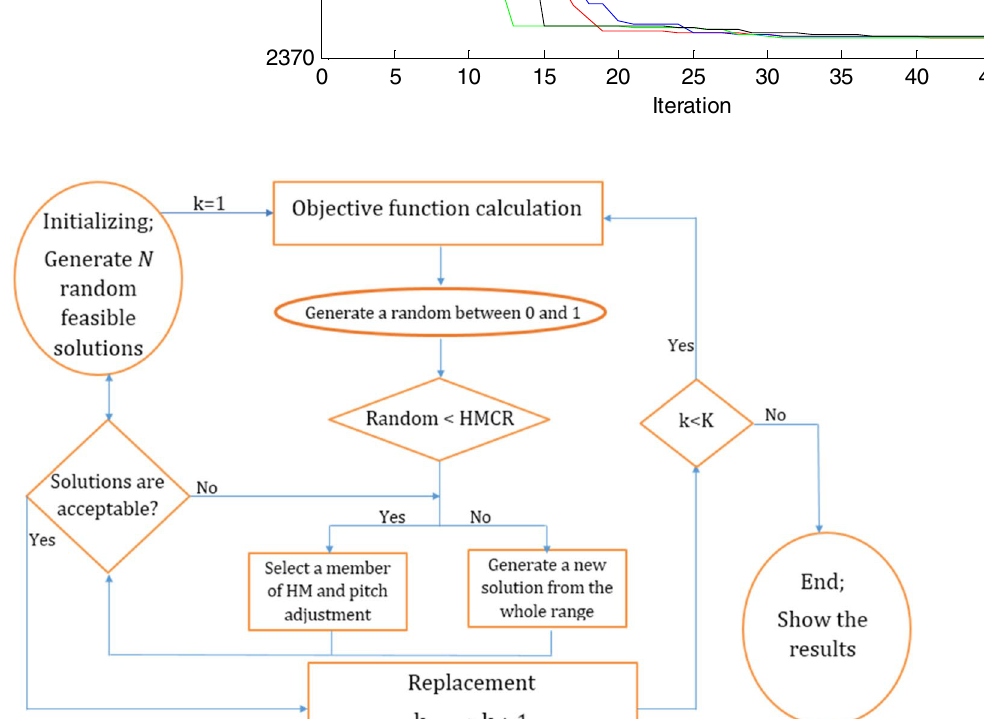
Fig. 10 Flowchart of HS applied to the wellbore path optimization problem. As for the GA, there is a string of components represent- ing a solution. Each component is responsible for a variable. Initially, a set of solutions is generated randomly and assembled as the har- mony memory (HM). Based on their fitness, established from their respective objective function values, the HM solutions are ranked. Applying a probabilistic selection method (a random number from the range 0–1, but closer to 1) a solution with high fitness from